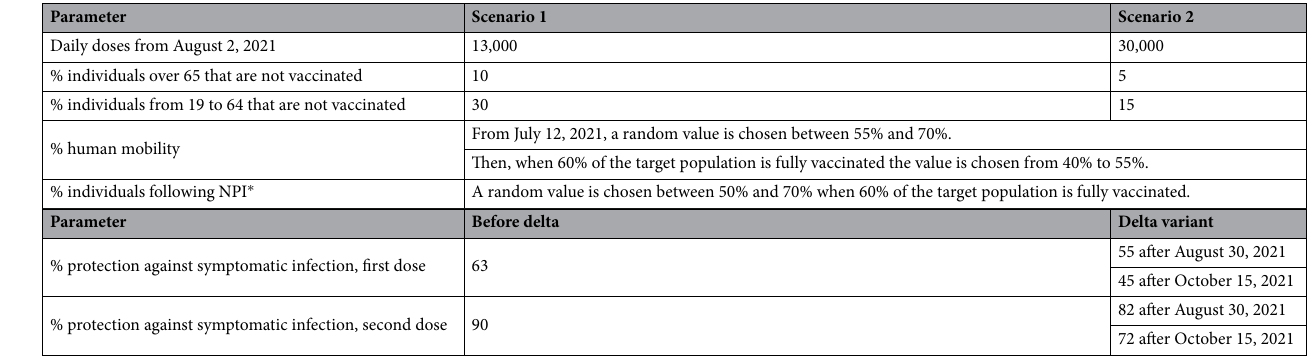
Table 1. Summary of scenarios. social distance.